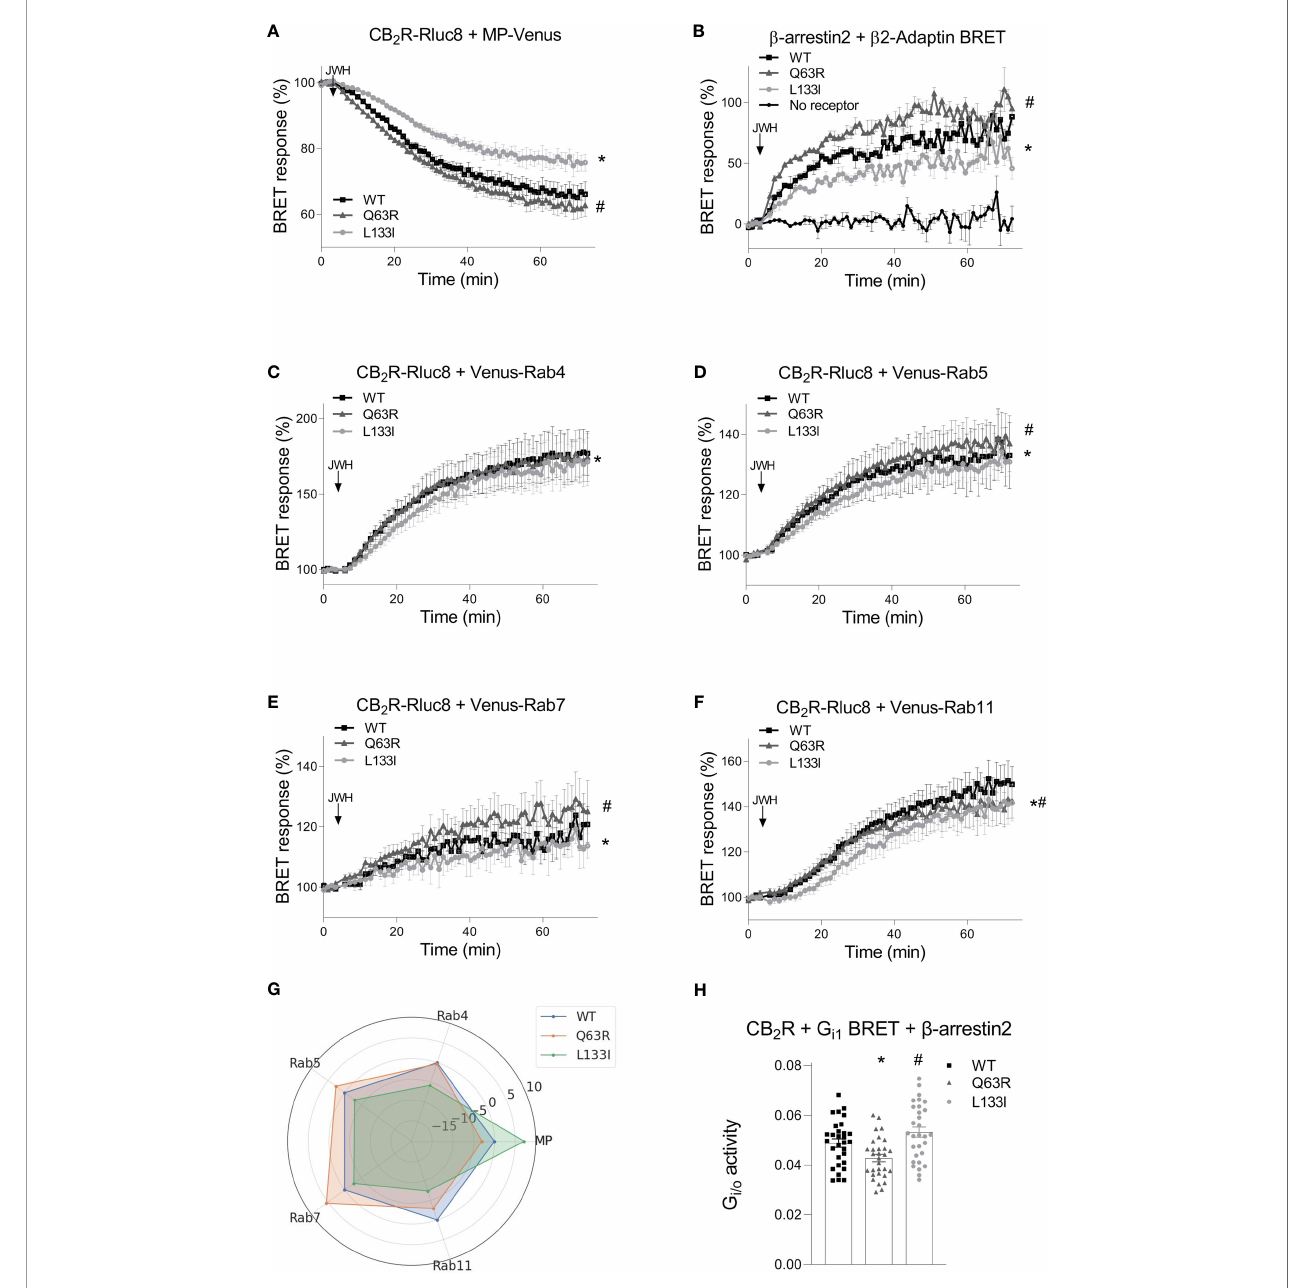
FIGURE 5 | CB2R intracellular traf fi cking and b -arrestin2 translocation followed by bystander BRET: CB 2 R-Rluc8-WT (black squares) CB 2 R-Rluc8-Q63R (grey triangles) and CB 2 R-Rluc8-L133I (grey circles) were co-expressed with Venus-tagged membrane markers. The cell membrane was labeled with MP-Venus (A) , rapid recycling endosomes with Venus-Rab4 (C) , early endosomes with Venus-Rab5 (D) , late endosomes with Venus-Rab7 (E) , and late recycling endosomes with Venus-Rab11 (F) . b -arrestin2-Rluc8 was coexpressed with a clathrin-coated pit marker, b 2-Adaptin-Venus (B) . The arrows show the time of the JWH-133 (10 µM) treatment. Statistical analysis was performed with two-way ANOVA (time, mutation) followed by Tukey ’ s post-hoc test with multiple comparisons. * and # indicate signi fi cant differences in pairwise comparisons, CB 2 R-L133I vs. CB 2 R-WT and CB 2 R-Q63R vs. CB 2 R-WT respectively (p<0.001). (G) Radial plot showing average differences compared to CB 2 R-WT across all timepoints. (H) HEK 293T cells were transfected with the indicated CB2R, G a i1 – Rluc8, Venus – b 1, g 2 and b -arrestin2 DNA constructs. Columns show G protein activation of the CB2 receptors: CB2R-WT (black squares) CB2R-Q63R (grey triangles) and CB2R-L133I (grey circles) in HEK 293T cells after 2 hour JWH-133 stimulation (10 m M). The mean of the negative D BRET (G protein activity) values from 5 independent experiments were compared by one-way ANOVA (repeated measures) and Tukey ’ s post-hoc test was applied for pairwise comparisons of the wild-type and mutant CB2R. *# indicates a signi fi cant difference between wild-type CB2R vs. CB2R-Q63R and CB2R-L133I vs. CB2R-Q63R (p<0.01). All technical replicates from the 5 independent experiments are